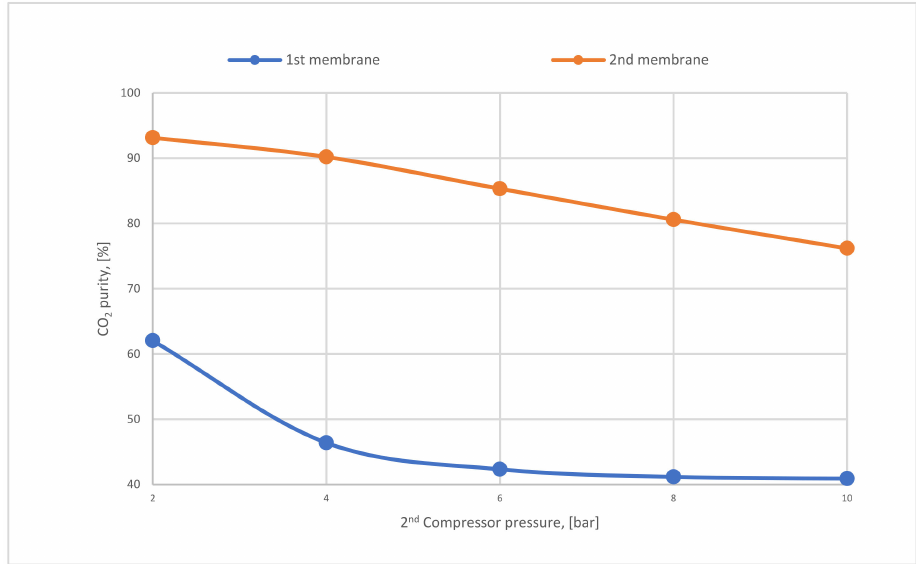
Figure 18. The difference in CO 2 purity at CP 1 of 4 bar, SA 1 of 600,000 m 2 , and SA 2 of 20,000 m 2 regarding various 2nd compressor